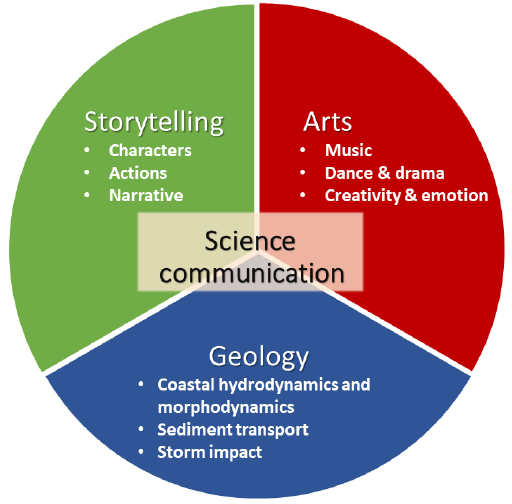
Figure 1. Scheme summarizing the elements from each component to develop the interdisciplinary